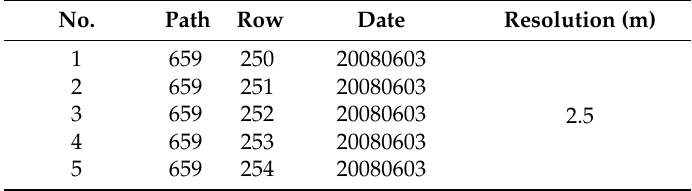
Table 1. Stereo pairs IRS-P5 Imagery used in post-earthquake DEM derivation.